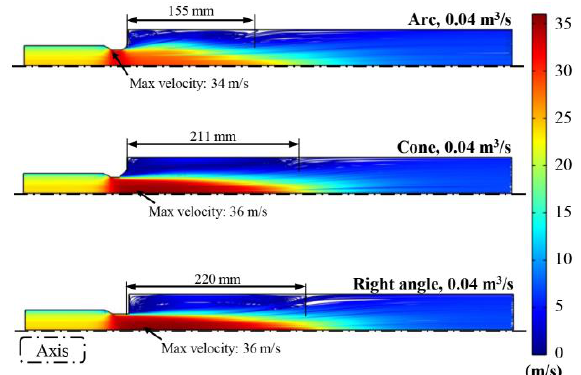
Figure 13. Effect of the outlet structure of the ball seat on the flow velocity; the fluid viscosity was set as 100 mPa·s.